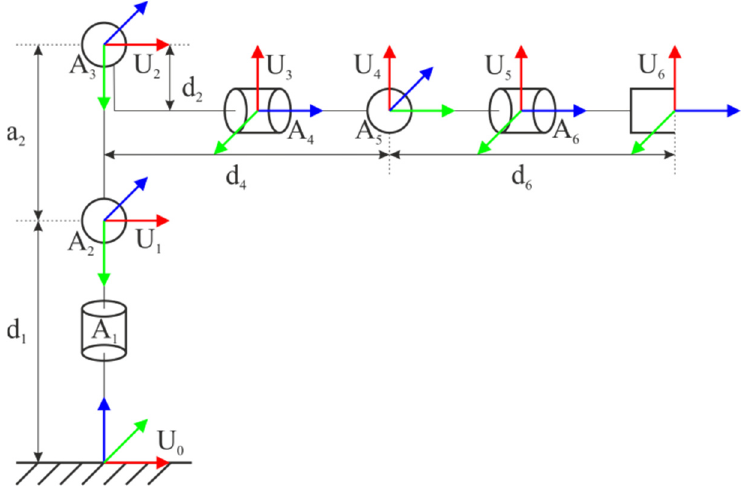
Figure A1. Kinematic diagram of the manipulator [27].